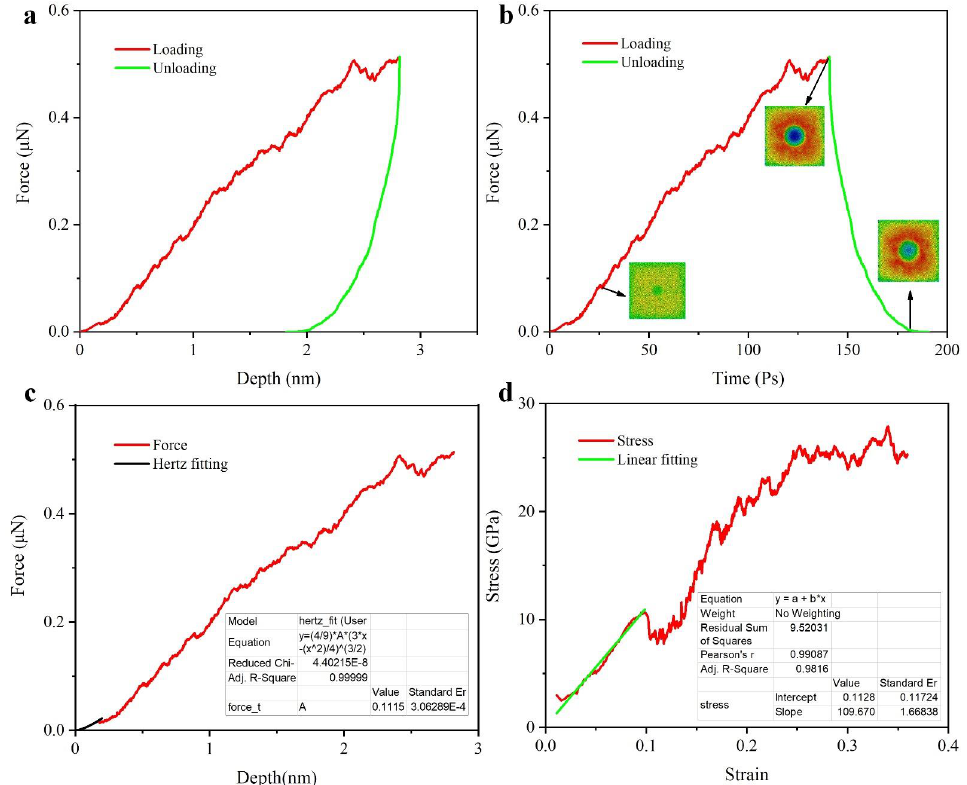
Figure 8. Indentation load curve. ( a ) Load-depth curve of simulated Ta-rich deposition output model; ( b ) Time-force of nanoindentation, three sub-images relate to the indentation depth at that time; ( c ) Load-depth curve of loading stage and Hertz fitting; ( d ) Strain-stress curve transfer from load-depth